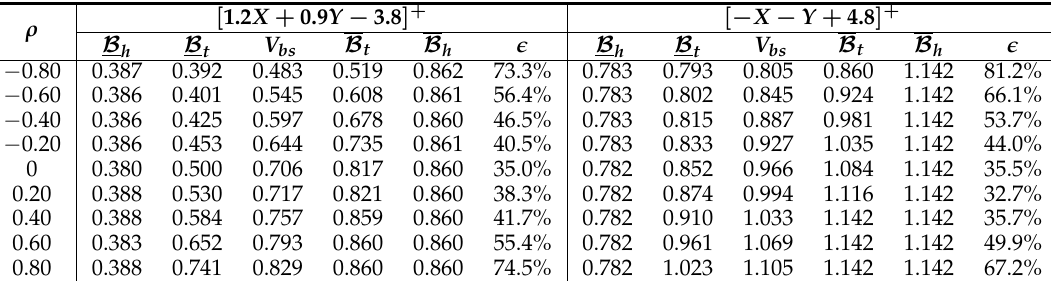
Table 2. Sensitivity of Valuation Bounds Against Correlation Coefficient. The time-zero prices of the exchange rates X and Y are 1.6 and 2.5. The volatilities of the processes X and Y are 42%. Both the domestic and foreign interest rate are zero. All prices are attained within a price mesh of u = 1.12 and J = 30. Two basket options mature at T = 1